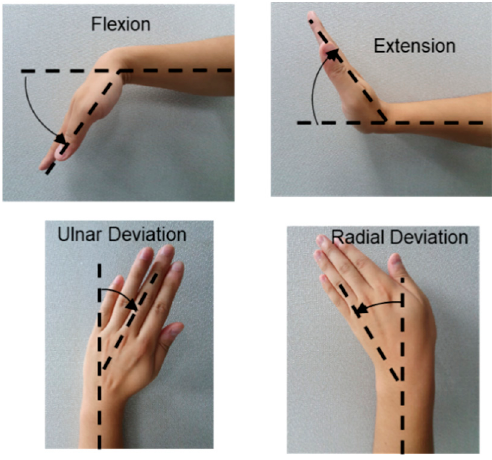
Figure 6. Four wrist motions.